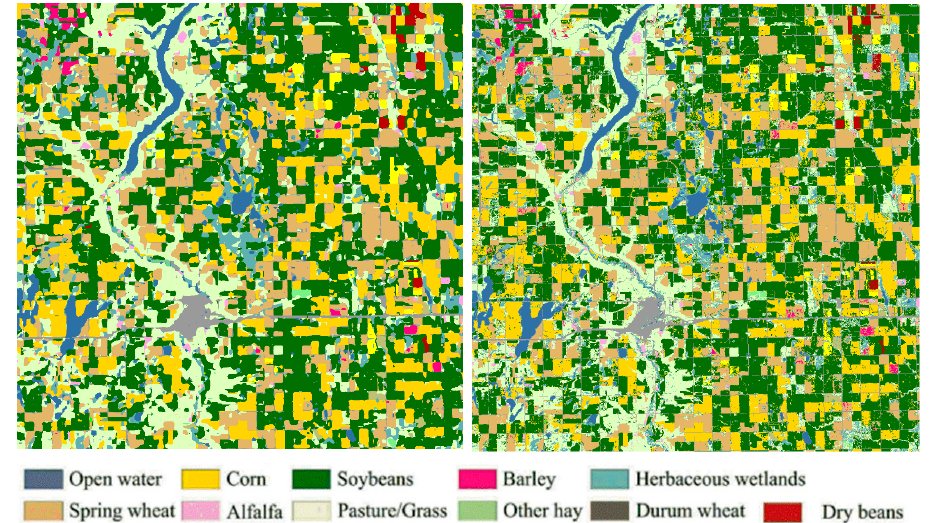
Figure 5. GeoWeaver-reproduced crop map (left) compared with United States Department of Agriculture (USDA) map (right).